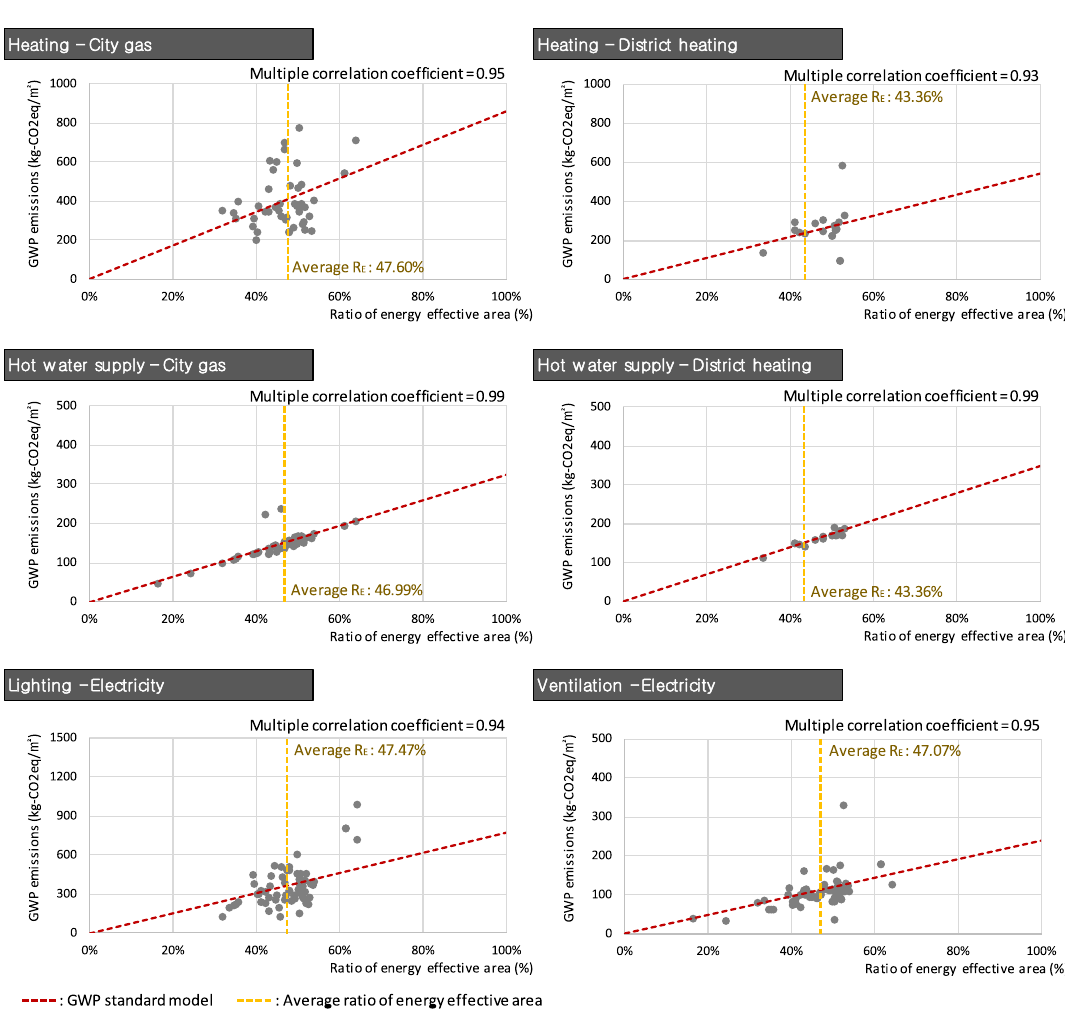
Figure 4. Linear regression analysis results by energy use and energy source of the